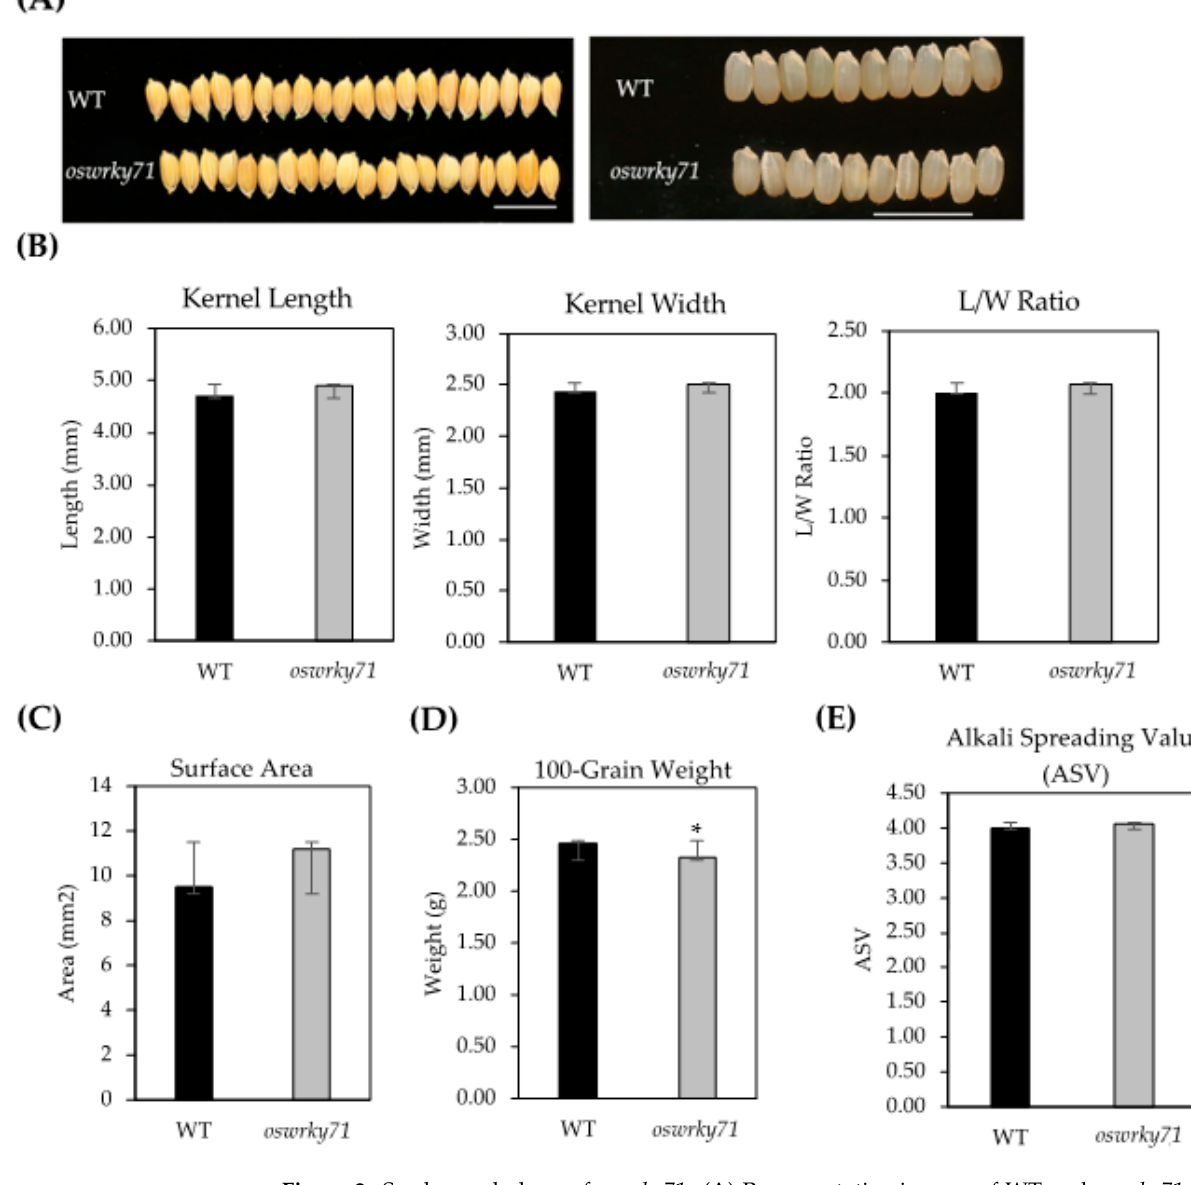
Figure 2. Seed morphology of oswrky71 . ( A ) Representative images of WT and oswrky71 mutant seeds. Scale bar = 1 cm. ( B ) Length, width, length–width (L/W) ratio, and ( C ) surface area of WT and oswrky71 mutant kernels. Error bars represent ± SD. n = 100 kernels. ( D ) 100-grain weight of WT and oswrky71 kernels. Error bars represent ± SD. n = 4 biological replicates, each with 100 kernels. ( E ) alkali spreading value (ASV) of WT and oswrky71 . Error bars represent ± SD. Asterisks indicate significance for one mutant relative to the wild type in Student’s t- test ( p < 0.05). n = 4 biological replicates, each with 4 kernels.